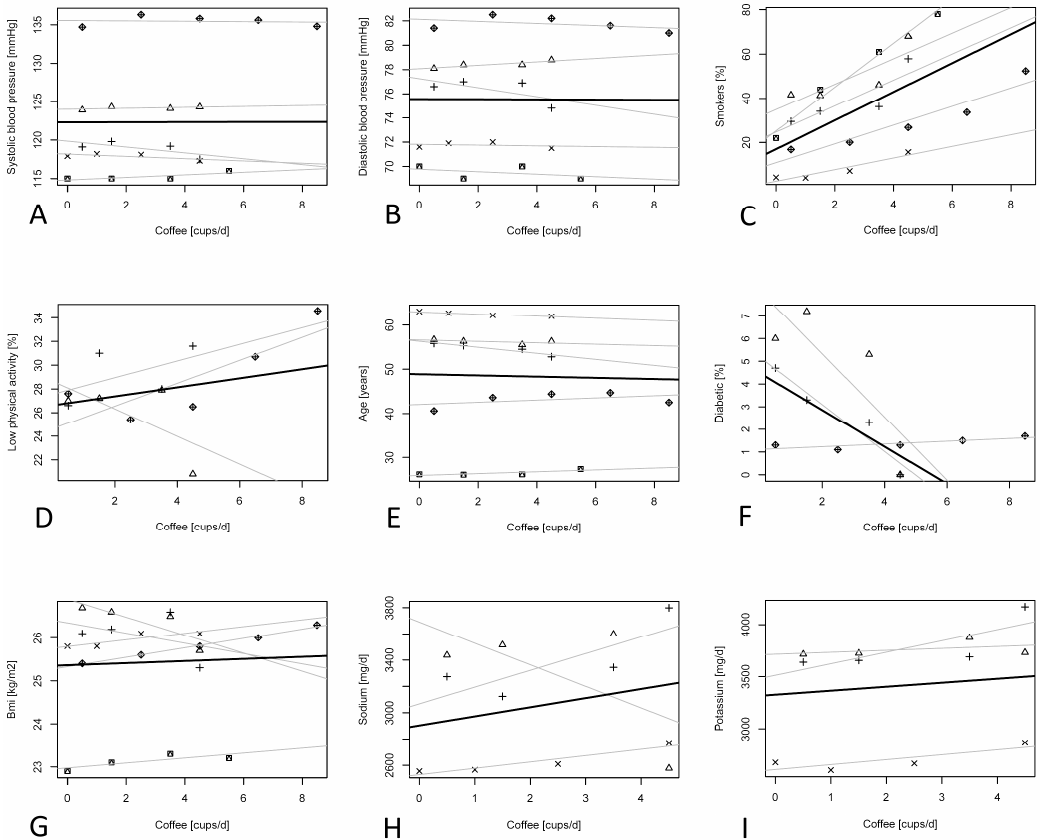
Figure 4. Scatter plots illustrating the relationship between coffee consumption (in cups per day) and baseline characteristics in the prospective cohorts: ( A ) systolic blood pressure; ( B ) diastolic blood pressure; ( C ) percentage of smokers; ( D ) percentage of low physically active individuals; ( E ) age; ( F ) percentage of diabetic individuals; ( G ) body mass index; ( H ) sodium intake; and ( I ) potassium intake. Symbols represent different cohorts; light lines represent linear regression coefficients of individual studies; bold lines represent summary estimates of average increase of each variable with increase in coffee intake. Cups/d: